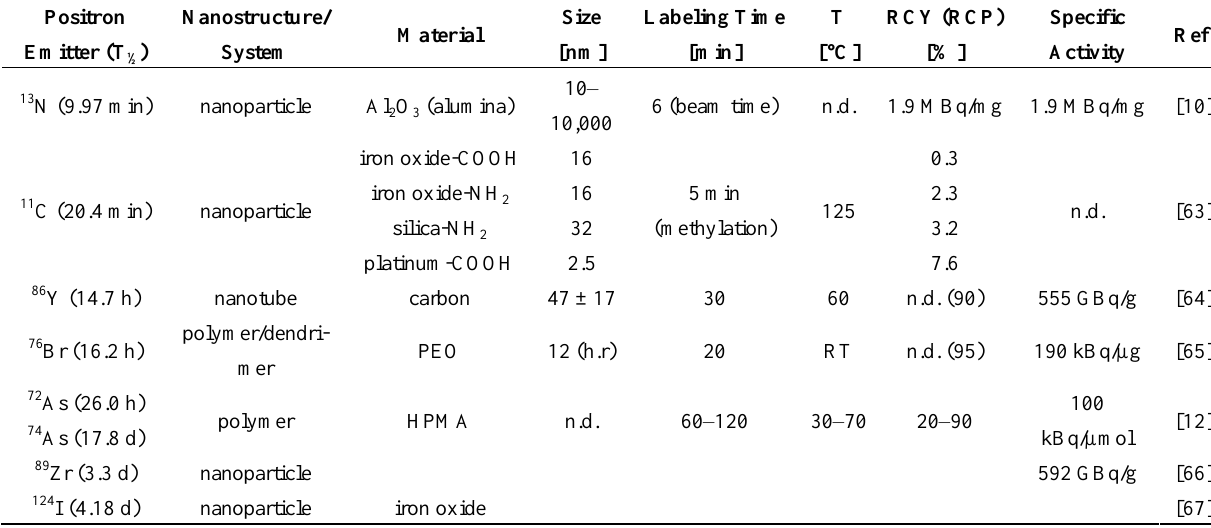
Table 5. An overview of radiolabeled nanoparticles and polymers using various